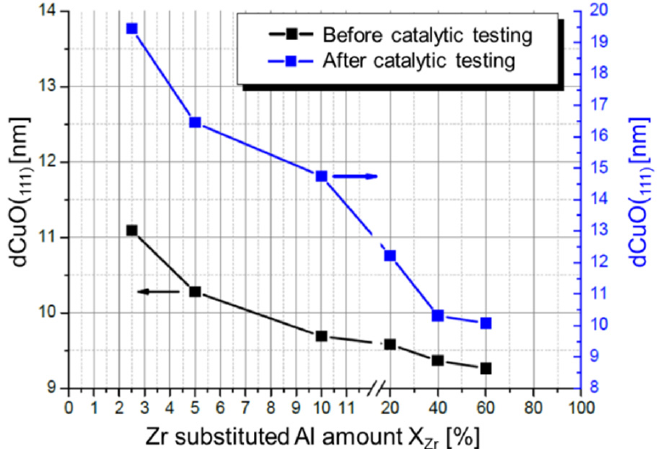
Figure 17. Calculated CuO crystallite size before and after the catalytic test depending on the amount of zirconium substituting Al. Catalyst system: Cu 0.61 Zn 0.21 Al 0.18-(0.18 · xZr) Zr (0.18 · xZr) , h equ = 600, T calc = 873 K, t calc = 2 h, heating rate = 1 K · min − 1 .